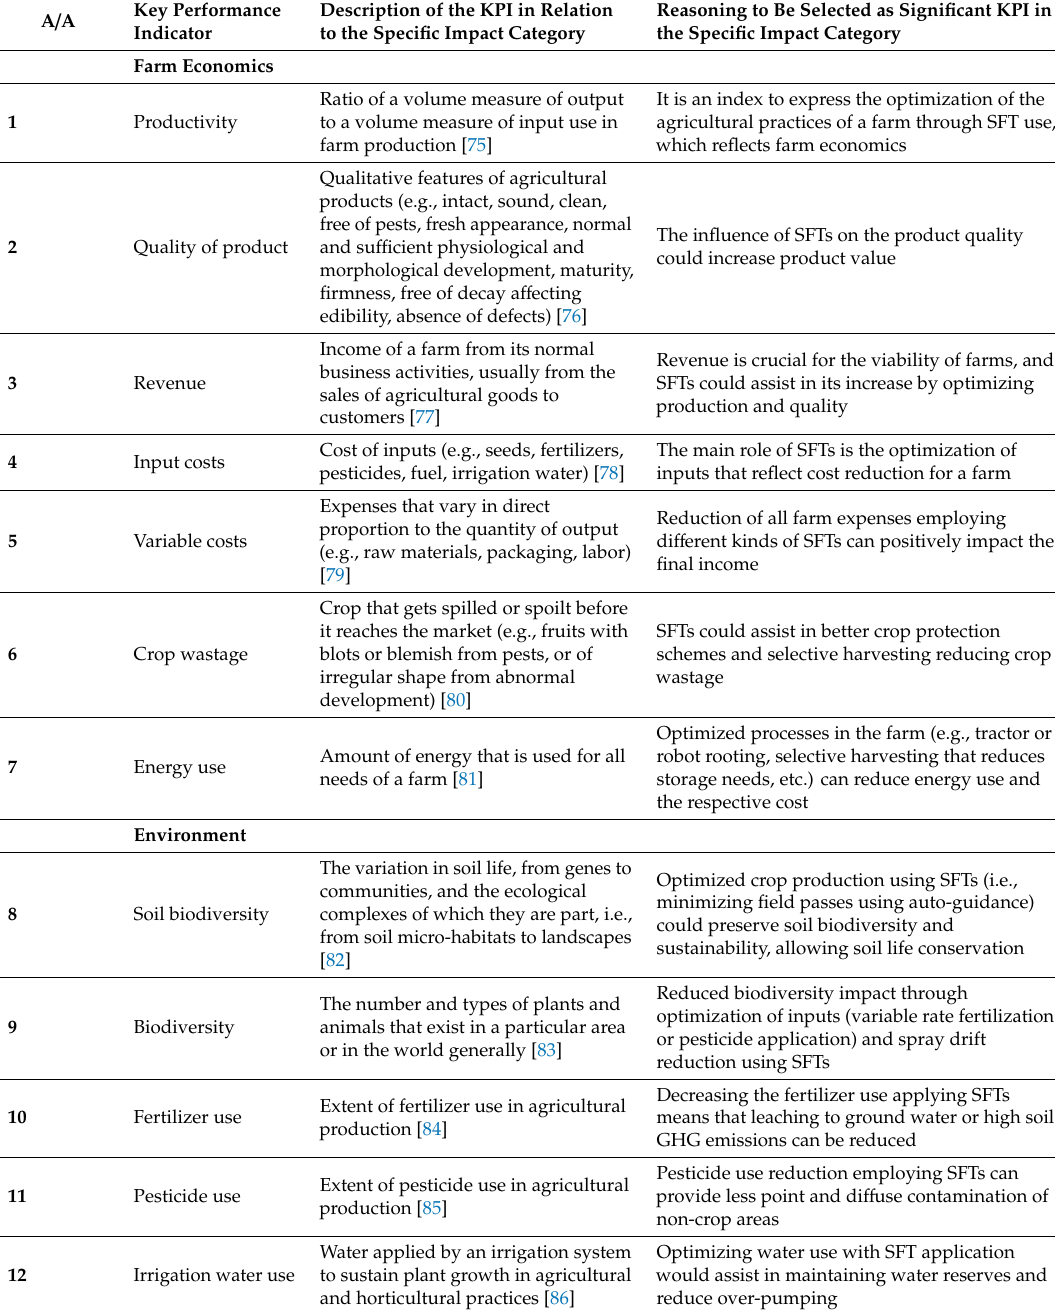
Table 2. Key performance indicators (KPIs) combined with their description and the reasoning for their inclusion to assess the impact of smart farming technologies (SFTs) in open–field farming, regarding farm economics, environment, and labor within the